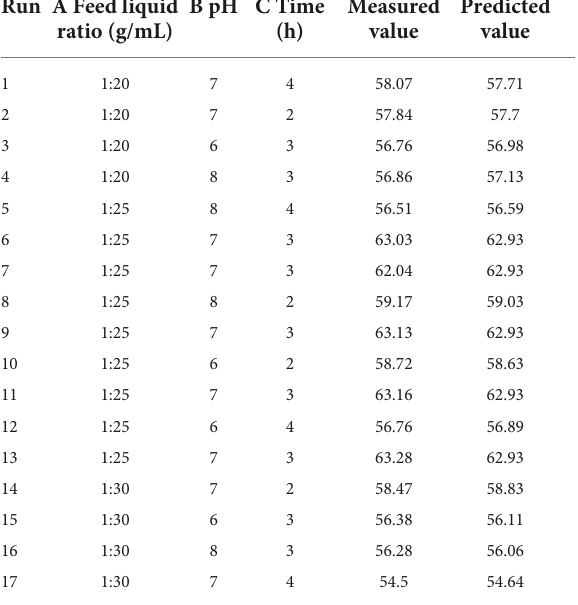
TABLE 3 Design and results of Box–Behnken